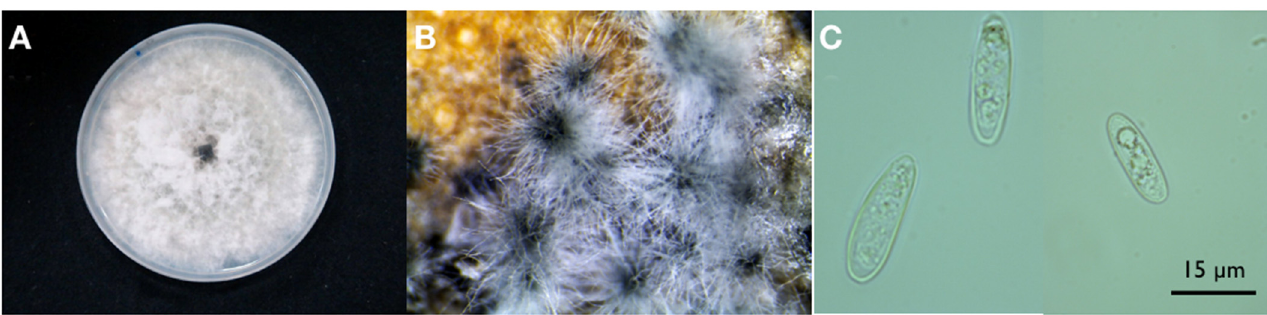
Figure 5. ( A ) Colony morphology of an isolate of Neofusicoccum parvum recovered from lemon on potato-dextrose-agar after 5 d incubation at 25 ◦ C; ( B ) Pycnidia developed on MEA containing sterilized pine needles; ( C ) Unicellular, ellipsoidal, thin-walled hyaline conidia of Neofusicoccum parvum mounted in sterile distilled water.